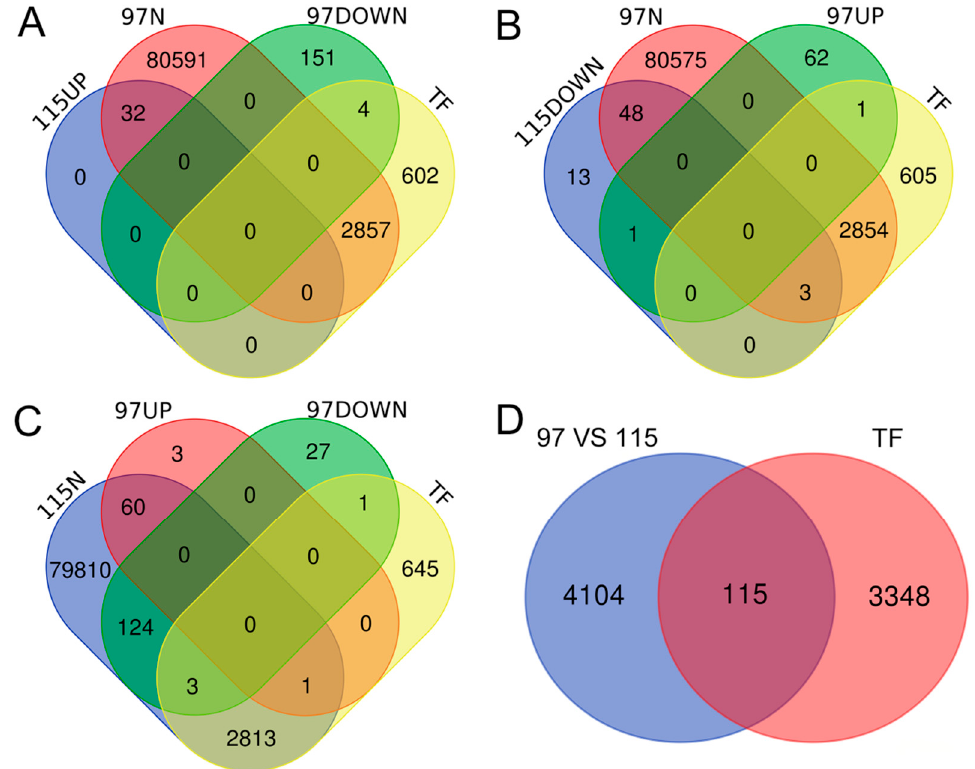
Figure 5. Venn diagrams showing the number of DEGs encoding TFs. Overlaps represent genes simultaneously di ff erentially expressed in two or three groups. 97UP: Up-regulated genes during the anther development of ‘Qx-097 (cid:48) . 97DOWN: Down-regulated genes during the anther development of ‘Qx-097 (cid:48) . 115UP: Up-regulated genes during the anther development of ‘Qx-115 (cid:48) . 115DOWN: Down-regulated genes during the anther development of ‘Qx-115 (cid:48) . 97N: Genes showing no di ff erential expression in the Qx-097-2 vs. Qx-097-1 comparison. 115N: Genes showing no di ff erential expression in the Qx-115-2 vs. Qx-115-1 comparison. 97 vs. 115: Genes that are not di ff erentially expressed during the anther development of ‘Qx-097’ or ‘Qx-115’, but di ff erentially expressed when ‘Qx-097’ compared with ‘Qx-115’. TF, all the transcription factor-encoding genes identified in our data. The comparison scheme is as follows: ( A ) 115UP ∩ (97N ∪ 97DOWN) ∩ TF, ( B ) 115DOWN ∩ (97UP ∪ 97N) ∩ TF, ( C ) 115N ∩ (97UP ∪ 97DOWN) ∩ TF, ( D )97 vs. 115 ∩